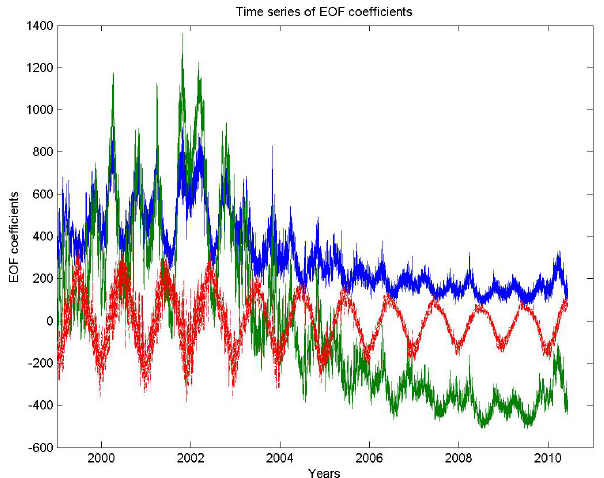
Figure 13. Time series of the principal components of the PCA for the first EOFs shown in Fig. 8: E amp ,E 1 ,n ,E 4 ,n – blue, green, red lines.